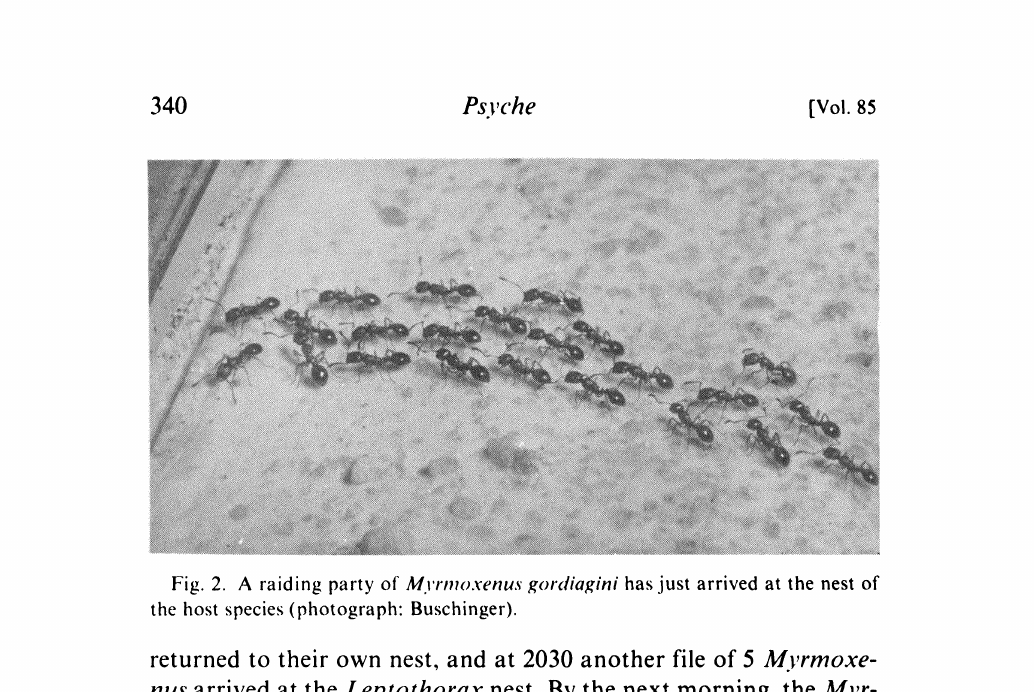
Fig. 2. A raiding party of Ml’rmoxenus gordiagini has just arrived at the nest of the host species (photograph: